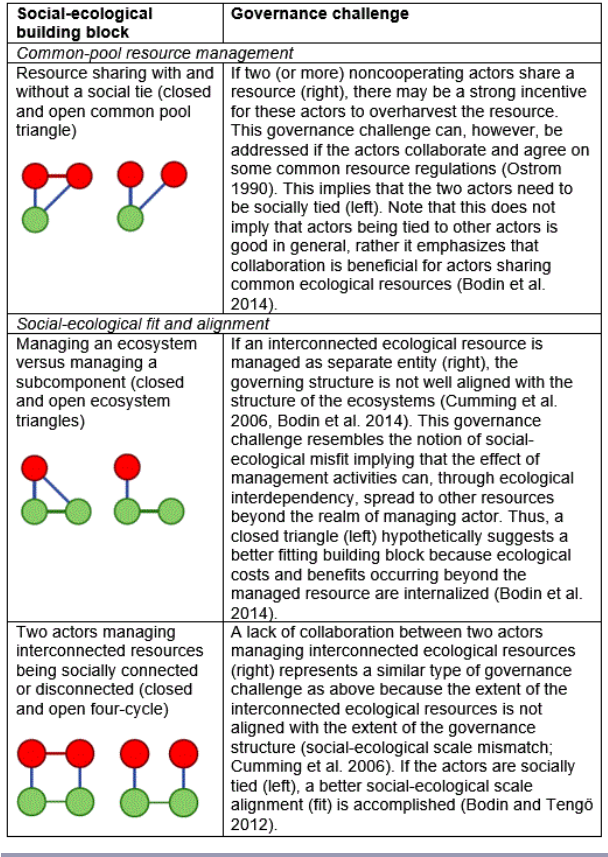
Fig. 2 . A set of minimal social-ecological building blocks and their hypothesized associations with a set of governance challenges. The building blocks capture an assumed relationship between governance processes and particular social-ecological structures. The red nodes represent managing actors, and the green nodes represent ecological resources. The desirable configurations (to the left) differ by the presence of one specific link in relation to the undesirable configurations (to the right). Please observe that these process/structure relationships are only hypothesized, and further research, beyond the scope of this study, is needed to fully test these